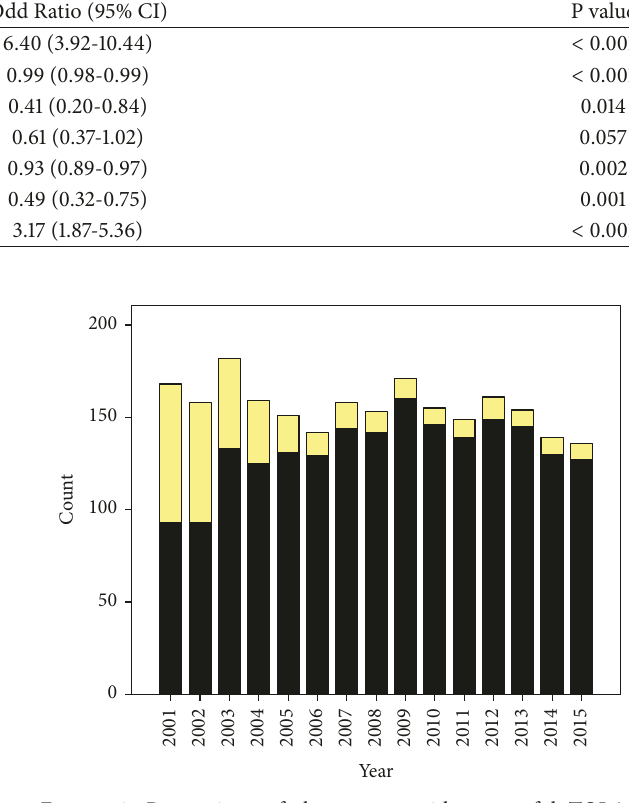
Figure 3: Proportions of the women with successful TOLAC (yellow) and repeated cesarean section (black) in each year.